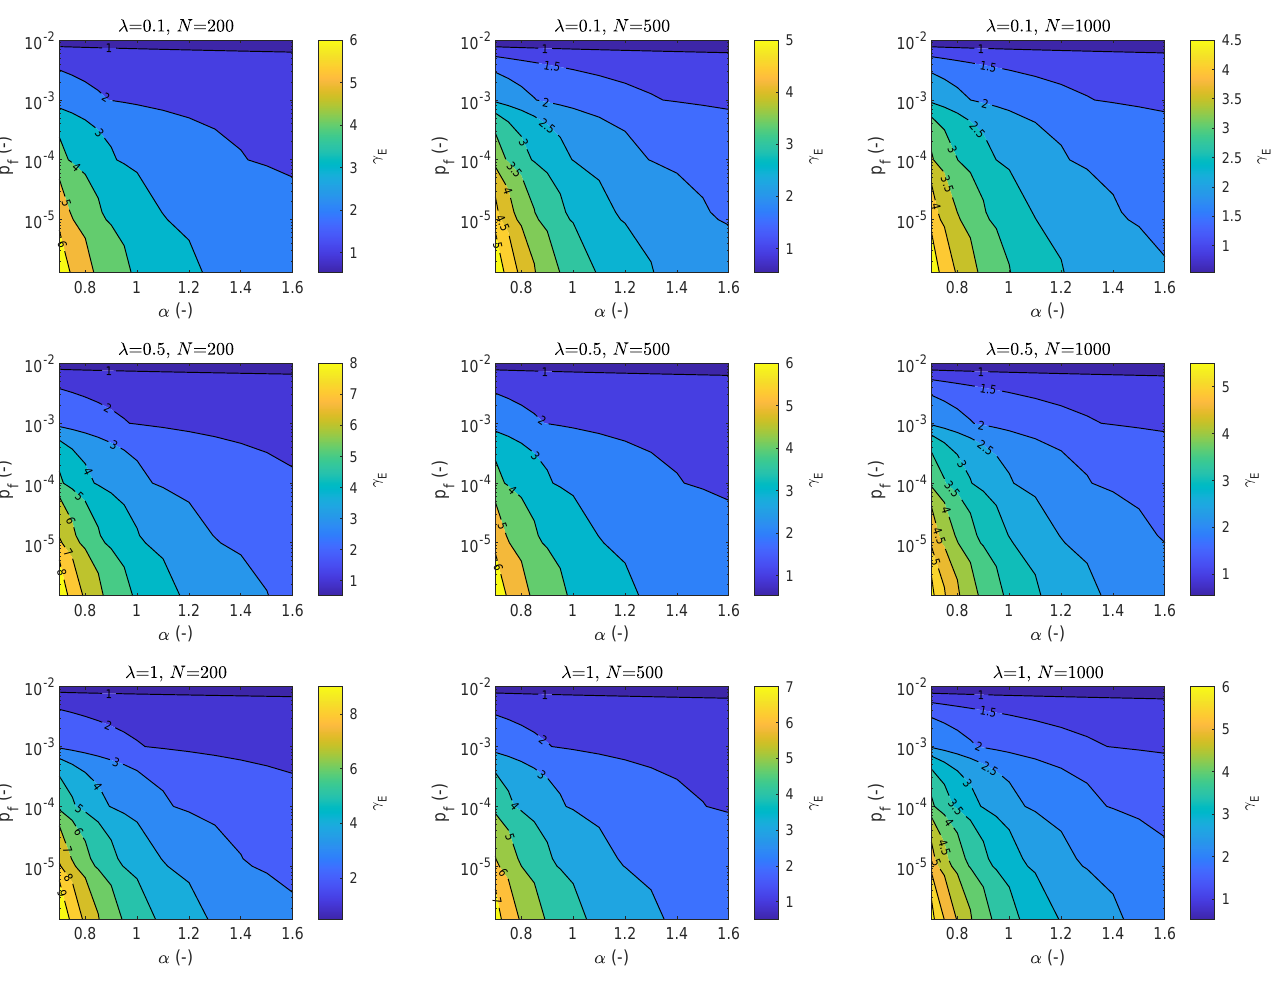
Figure 8. Partial safety factor related to the energy, γ E , for variable failure probabilities considering a reference block mass having a return period T k = 200